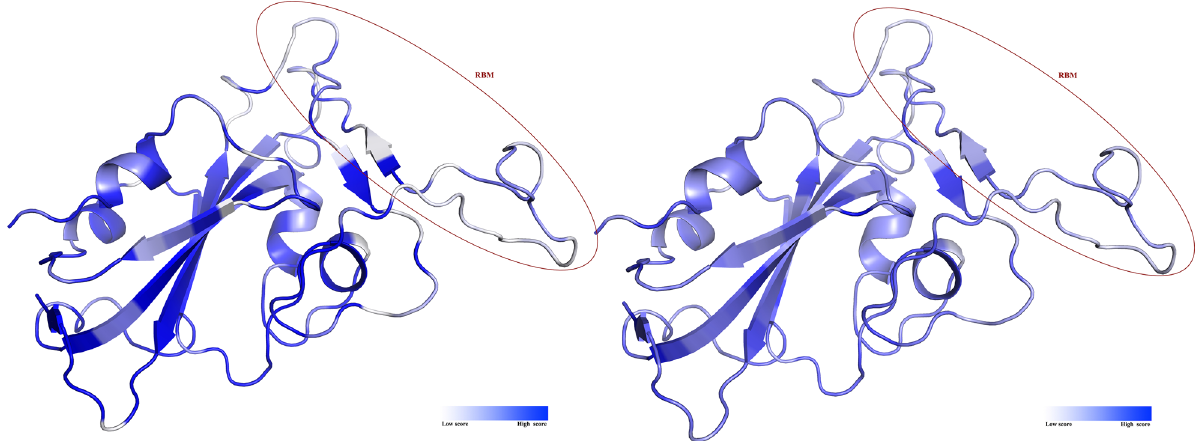
Figure 5. Stereo view of RBD. The ribbon on the left panel is colored based on the identity score; and the ribbon on the right panel is colored based on the similarity scores. The scores were calculated based on BLOSUM62 by